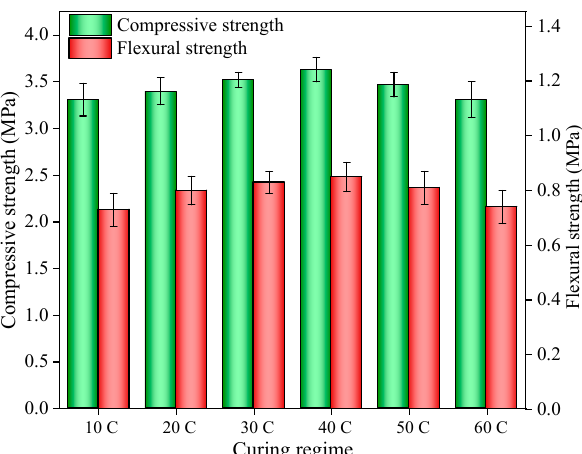
Figure 3. Compressive strength and flexural strength of ACP under different early curing regimes.